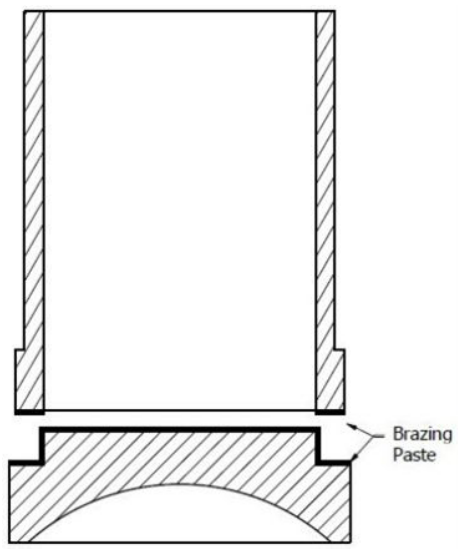
Figure 4. Schematic drawing for the brazing paste application.